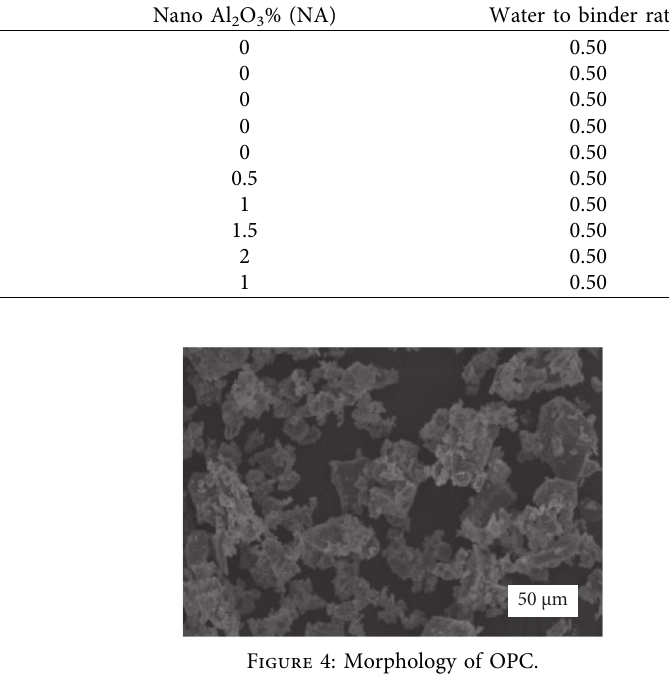
Figure 4: Morphology of OPC.